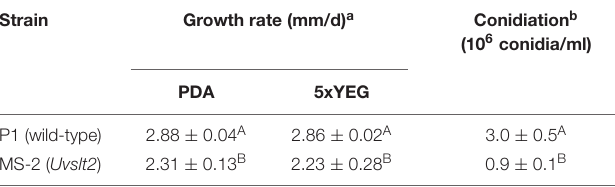
TABLE 2 | Defects of the Uvslt2 mutant in growth and